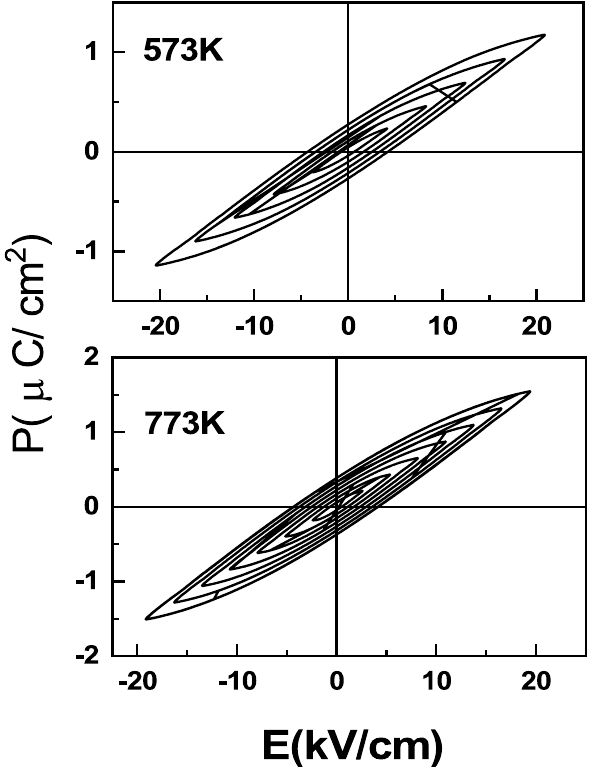
Figure 4. P-E loop as obtained in the precursor gel subsequent to calcination at different temperatures viz . , 573 and 773 K